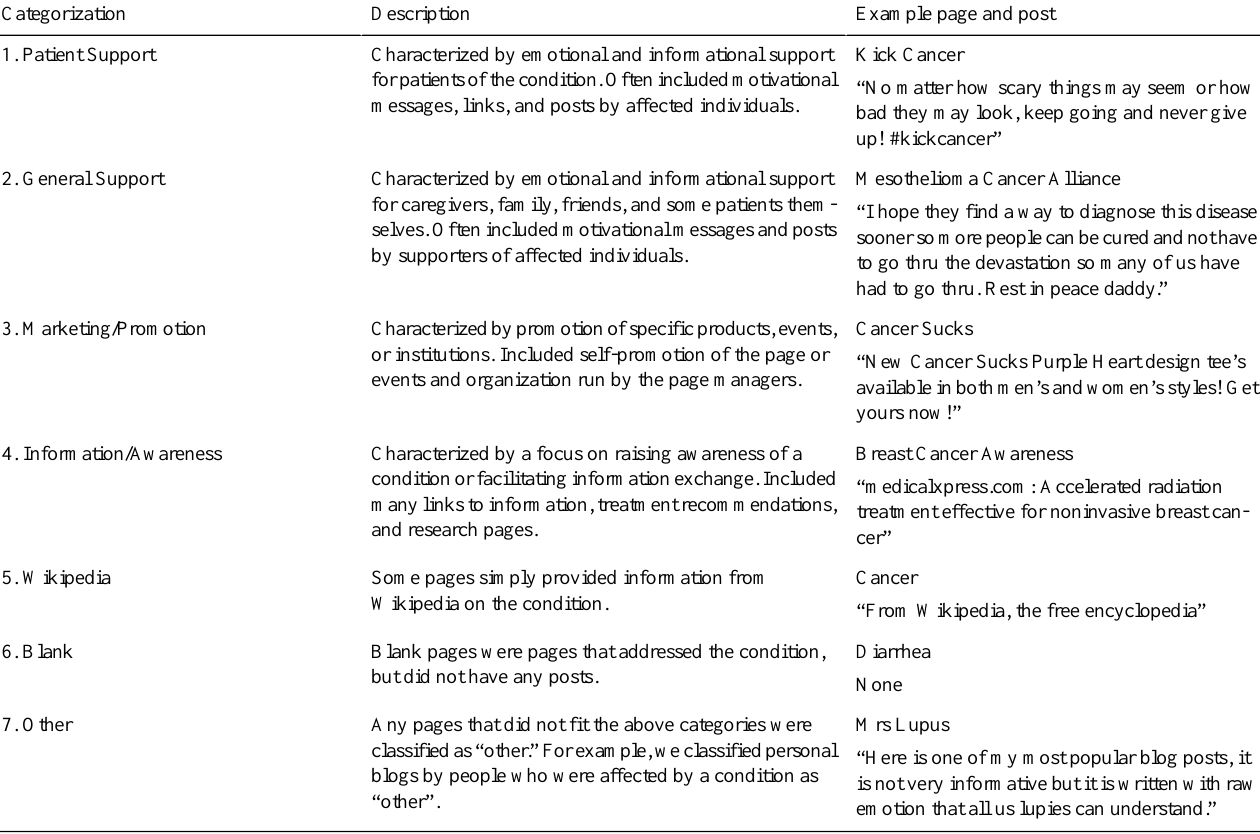
Table 2. Page categorization and example posts.